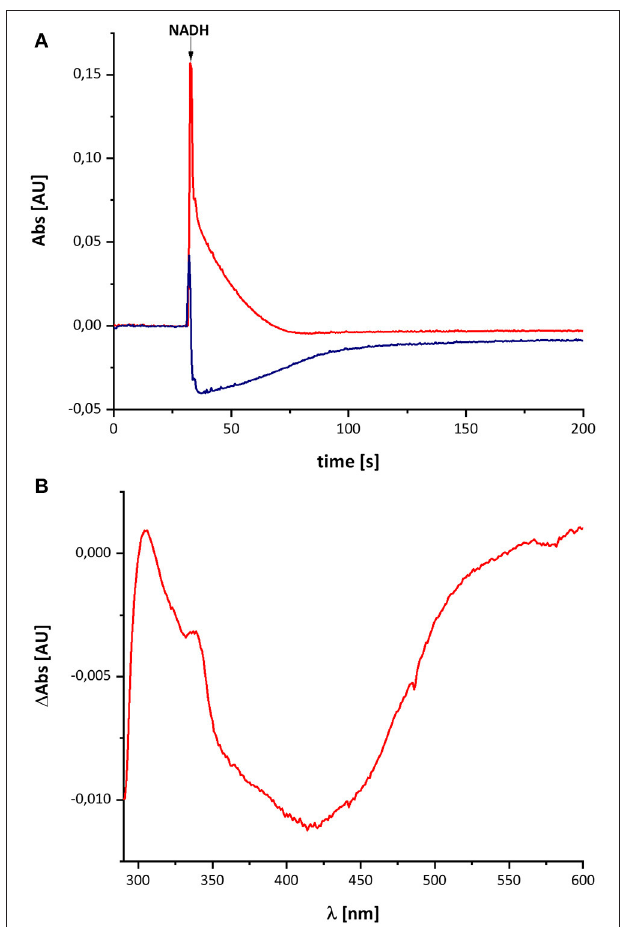
FIGURE 6 | Reduction of the D213G H variant by NADH followed by partial re-oxidation by oxygen from the air. (A) The red trace shows the absorbance of NADH at 340nm and the blue trace that of the complex I at 450nm. (B) Shows the (reduced-minus-oxidized) difference spectrum observed after 2min after the addition of NADH.